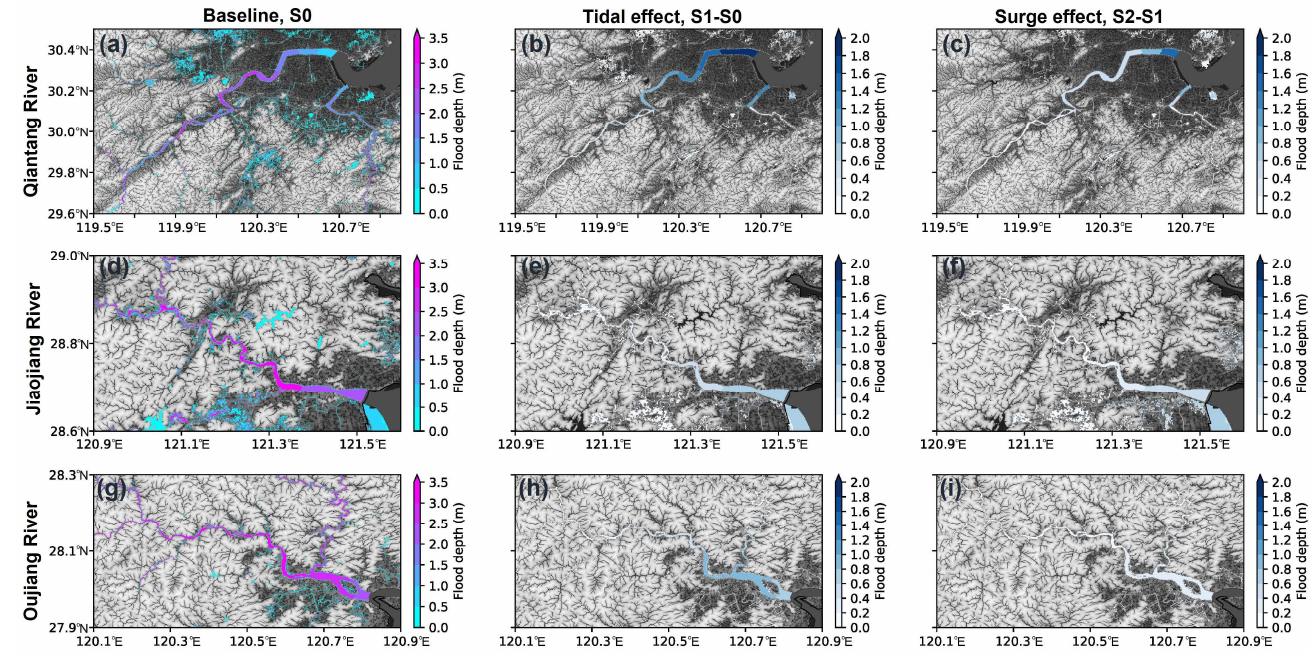
Figure 11. Maximum inundation based on the daily mean flood depth in the basins of ( a – c ) QR, ( d – f ) JR, and ( g – i ) OR during Typhoon Lekima (9–15 August 2019). Subplots ( b , e , h ) represent the maximum flood depth differences between S1 and S0. Subplots ( c , f , i ) represent the maximum flood depth differences between S2 and S1.